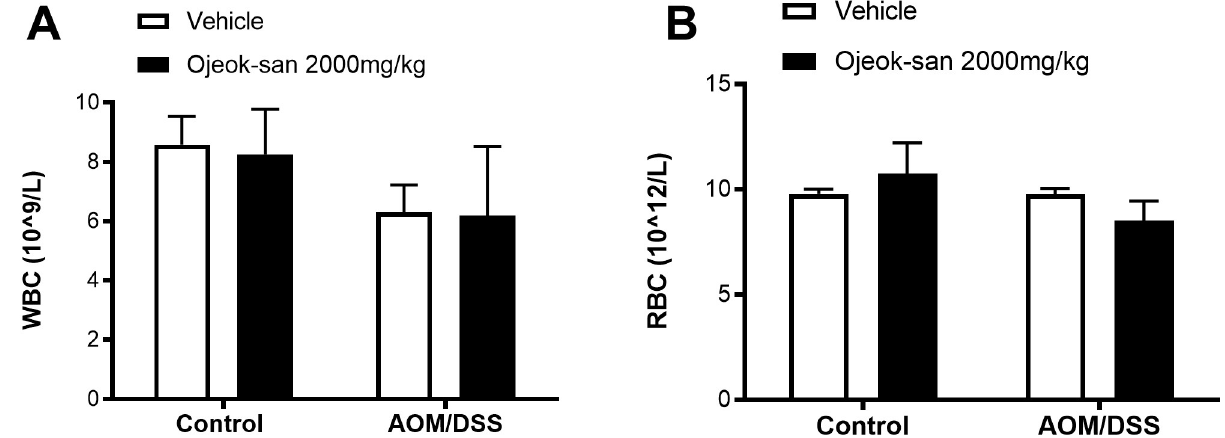
Fig 4. OJS administration did not elicit changes in cell blood counts. (A) White blood cells and (B) Red blood cells were measured using a VetScan HMT. Two-way ANOVA, n = 8–9 in Control non-cancer group and n = 4–7 in AOM/DSS